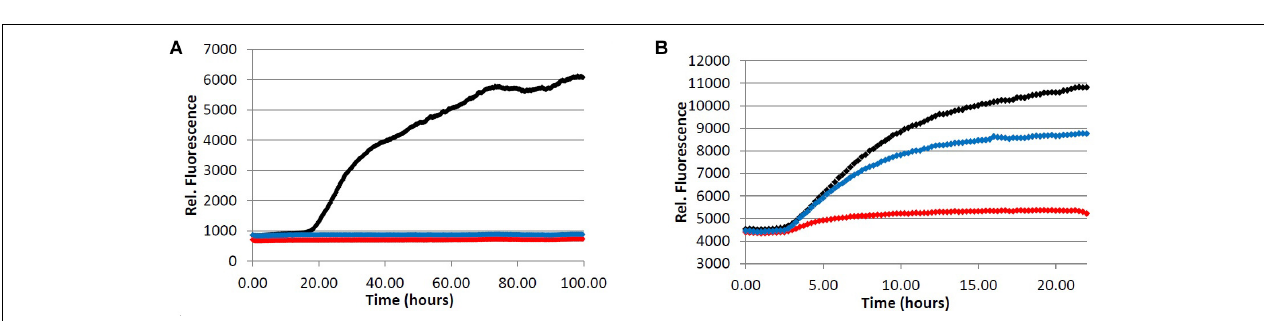
FIGURE 4 | (A) Fibrillization of A β peptide. 20.0 µ M A β 1 − 40 in Tris buffer (20.0 mM, pH 7.4, 150 mM NaCl) was incubated at 37.0 ◦ C in the presence of 4.0 µ M ThT and 100 µ M of analyte. (B) Fibrillization of tau protein. 4.0 µ M tau in Tris buffer (50.0 mM, pH 7.4, 10.0 µ g/mL heparin, 1.0 mM dithiothreitol, 50.0 mM sodium azide) was incubated at 37.0 ◦ C in the presence of 5.0 µ M ThS and 100 µ M of analyte. (red) = chlorogenic acid ( 2 ), (green) = quinic acid ( 3 ), (purple) = caffeic acid ( 4 ), (blue) = quercetin ( 5 ), (black) = no compound (vehicle control).